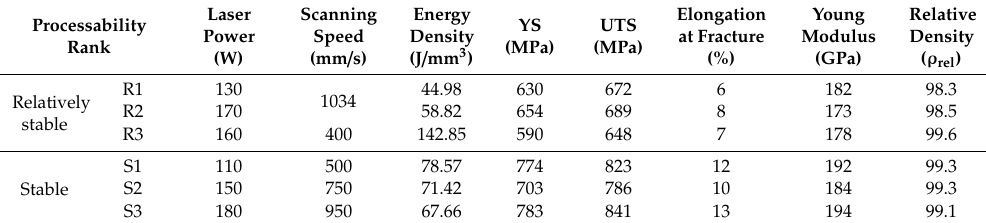
Table 4. Tensile test results of SLM-processed 316L samples.